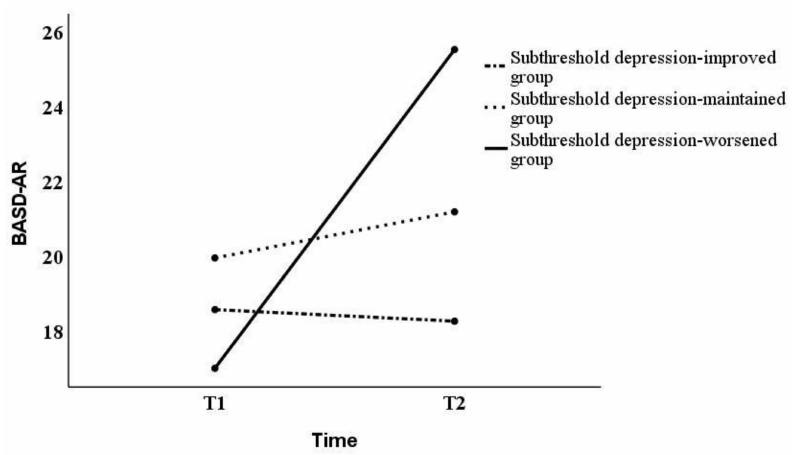
Figure 1. Changes in BADS-AR score from T1 to T2. BADS-AR, Behavioral Activation for Depression Scale—Avoidance/Rumination.